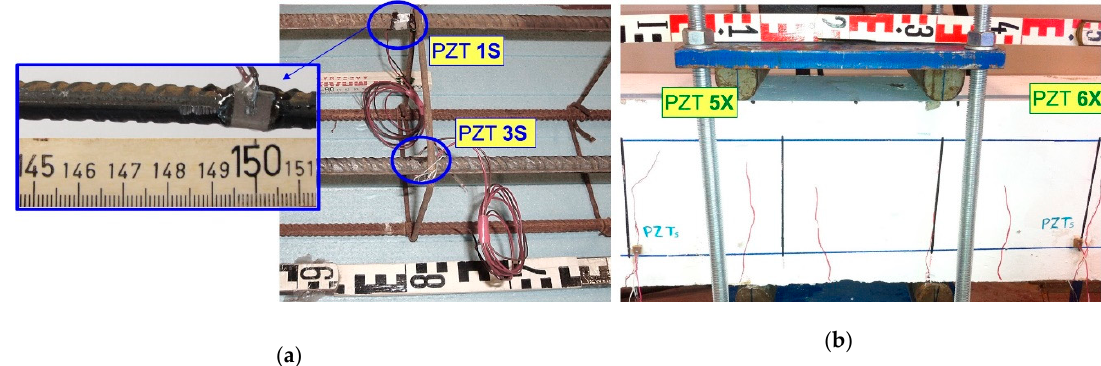
Figure 4. Installation of PZT patches ( a ) internally epoxy-bonded on the steel surface of the tension reinforcing bars; ( b ) externally epoxy-bonded to the concrete surface.